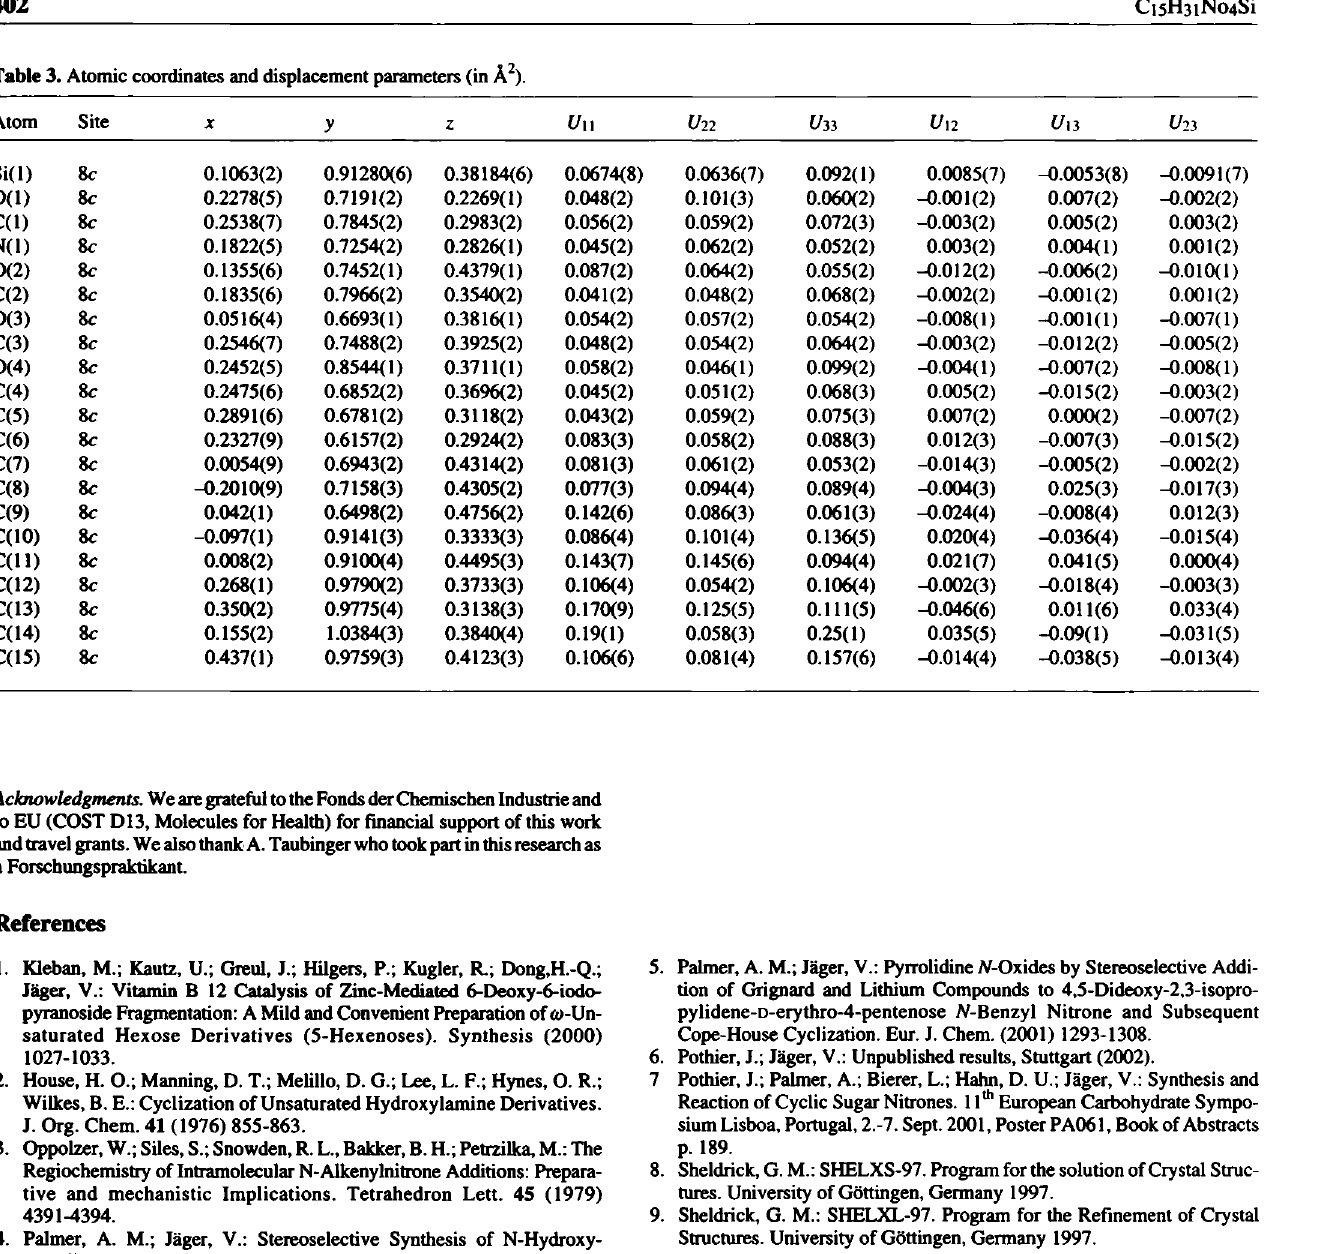
Table 3. Atomic coordinates and displacement parameters (in Â 2